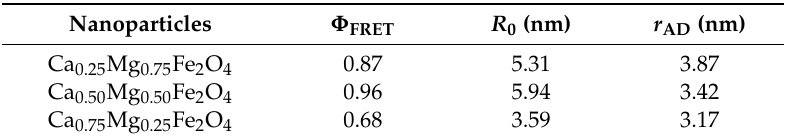
Table 5. FRET e ffi ciencies ( φ FRET ), Förster radii (R 0 ) and donor–acceptor distances (r AD ) calculated for the formation of the lipid bilayer in solid magnetoliposomes.